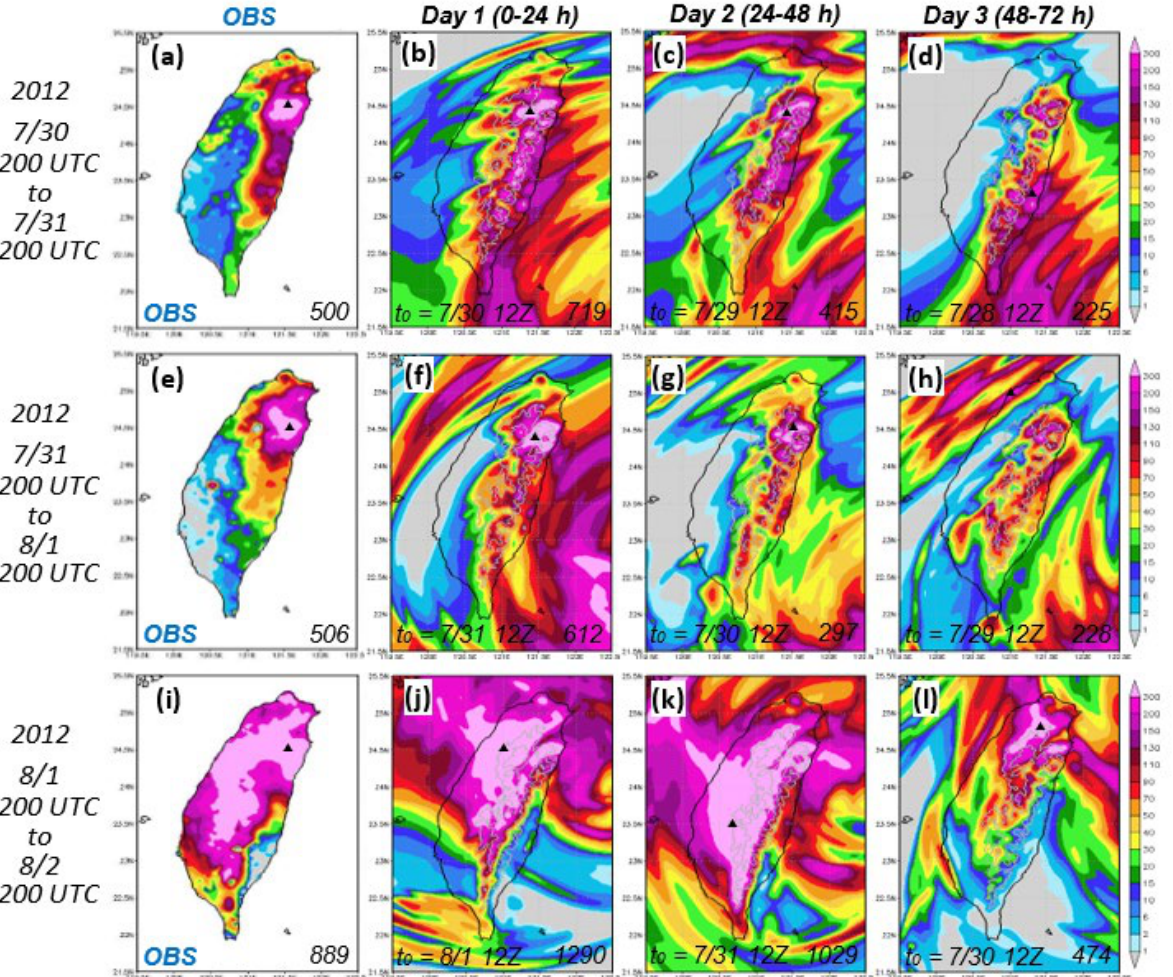
Figure 4. ( a ) Observed 24 h rainfall distribution (mm) over Taiwan starting from 1200 UTC of 30 July 2012, and CReSS 24 h QPFs (all targeted for the same period) made at 1200 UTC of ( b ) 30 July (day 1, 0–24 h), ( c ) 29 July (day 2, 24–48 h), and ( d ) 28 July (day 3, 48–72 h), respectively, during TY Saola (2012). ( e – h ) and ( i – l ) as in ( a – d ), except for observed and predicted rainfall for the 24 h period starting from ( e – f ) 1200 UTC of 31 July and ( i – l ) 1200 UTC of 1 August, respectively. The observed or predicted peak rainfall amount (mm, lower right), its location (triangle), and t 0 of forecast (lower left, columns 2–4 only) are all labeled. For the peak rainfall in QPFs, results are obtained after spatial interpolation onto locations of gauge sites. The color scales (to the right) are identical for all panels.